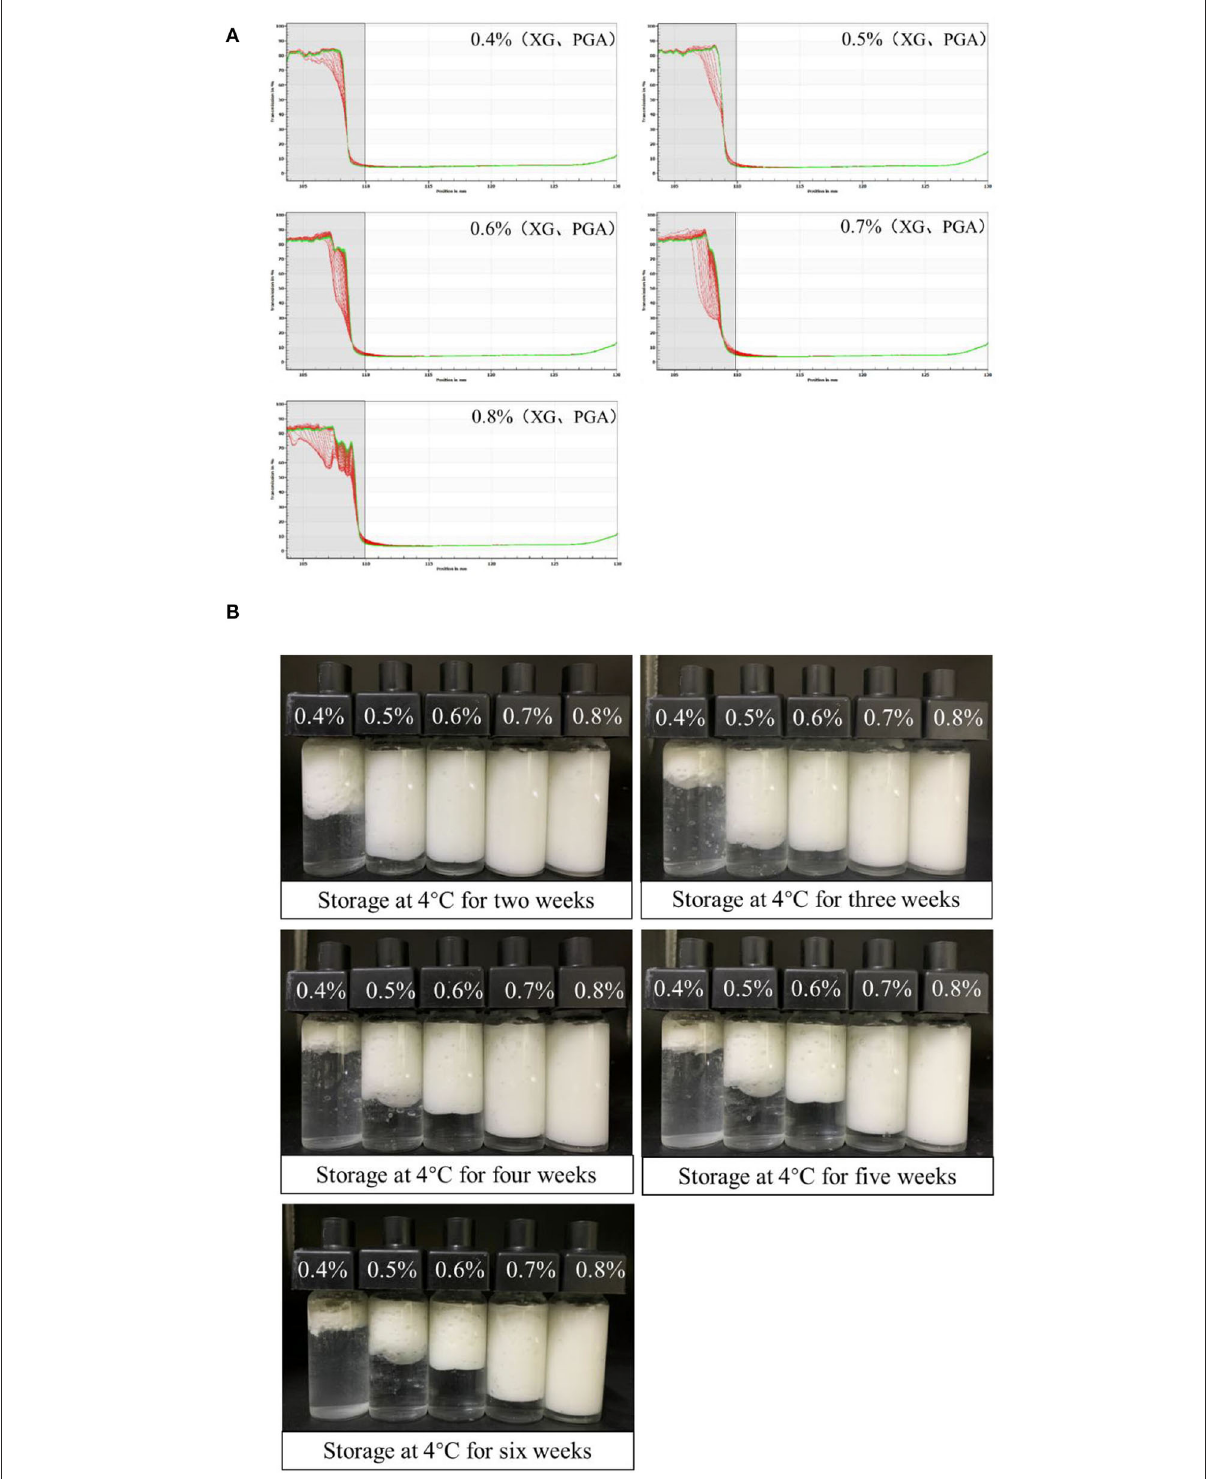
FIGURE2 Physical stability tested by LUMiSizer [ (A) , original transmission] of PGA-XG complexes stabilized S/O/W calcium-lipid emulsions as a function of concentrations. All the first profiles lie at the bottom, the last profiles lie at the top. Visual images (B) of the creaming stability of Solid-in-Oil-in-Water (S/O/W) calcium-lipid emulsions stabilized by different concentrations of PGA-XG complexes (0.4, 0.5, 0.6, 0.7, and 0.8 wt%) during 42 days of storage at 4 ◦